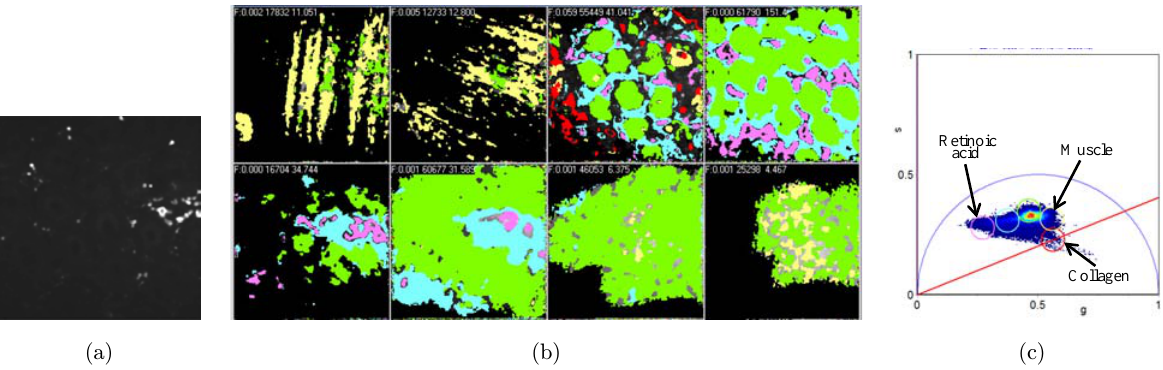
Fig. 10. Intensity image of the crypts (a), the FLIM images (b), and the phasor-plot (c) of the mouse small intestine.